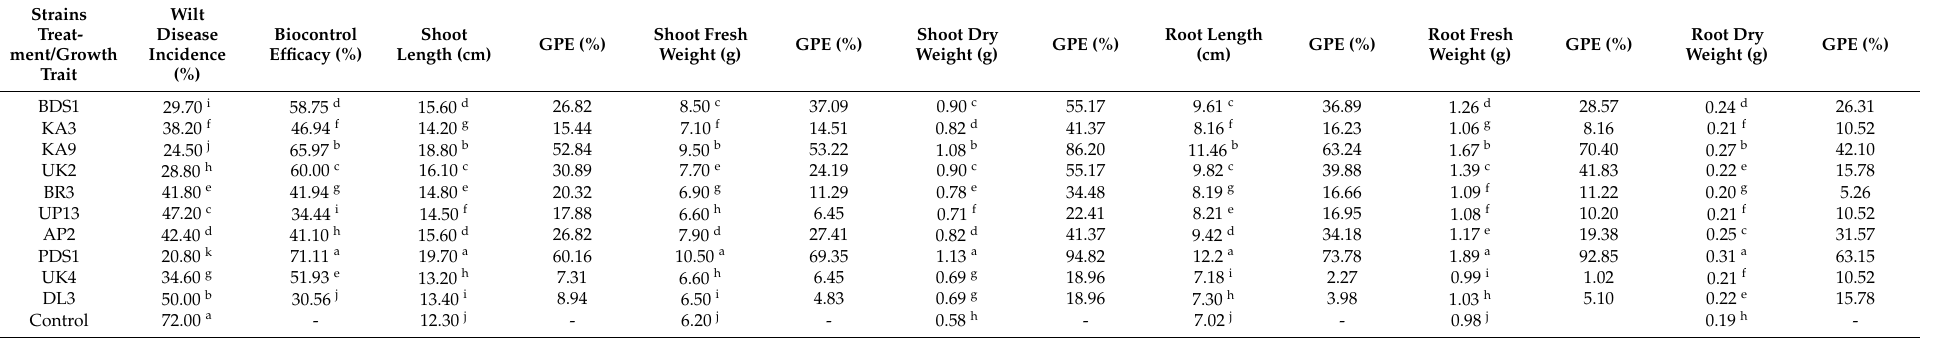
Table 3. Evaluation of potential antagonistic rhizobacteria on growth promotion of chilli cv. Pusa Jwala at 30 days after inoculation under glasshouse condition. Strains Treat- ment/Growth